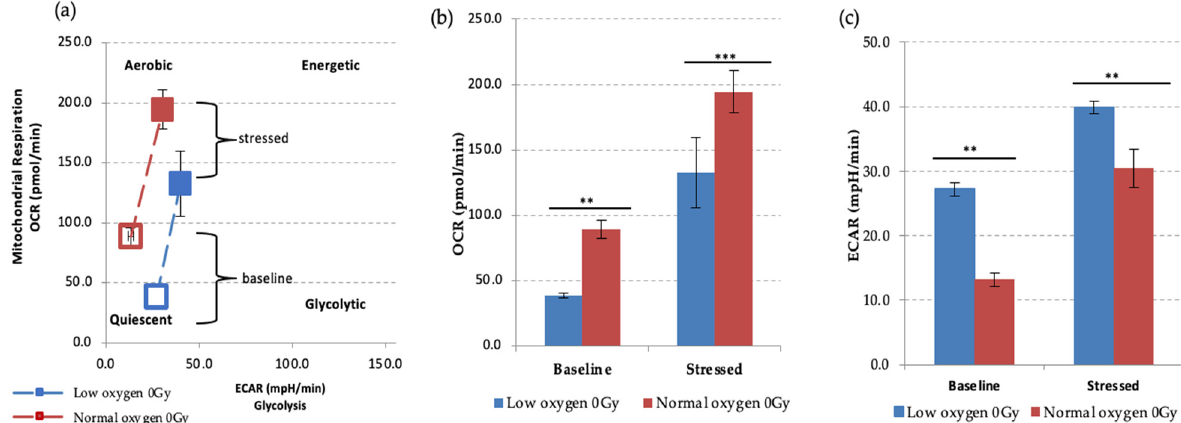
Figure 4. Seahorse XF Cell Energy Phenotype Test. ( a ) The phenotype map of HSPCs under basal and stress states. Non-IR exposed HSPCs were harvested from day 7 expansion cultures ( N = 3, error bars represent ±SEM) ( b , c ) Basal and stressed OCR and ECAR measurements in HSPC under normoxic and low O 2 conditions. Student t-test was applied to compare OCR (low oxygen vs. normal oxygen) and ECAR (low oxygen vs. normal oxygen). Asterisk * represents the significance difference; ** p < 0.05, *** p < 0.005.